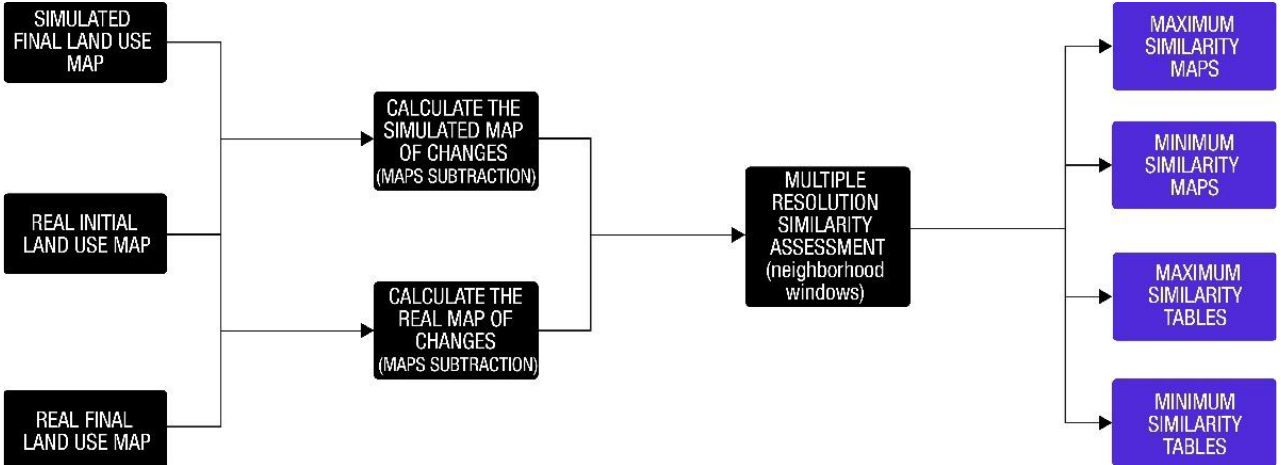
Figure 10. Simplified flowchart of the validation step.